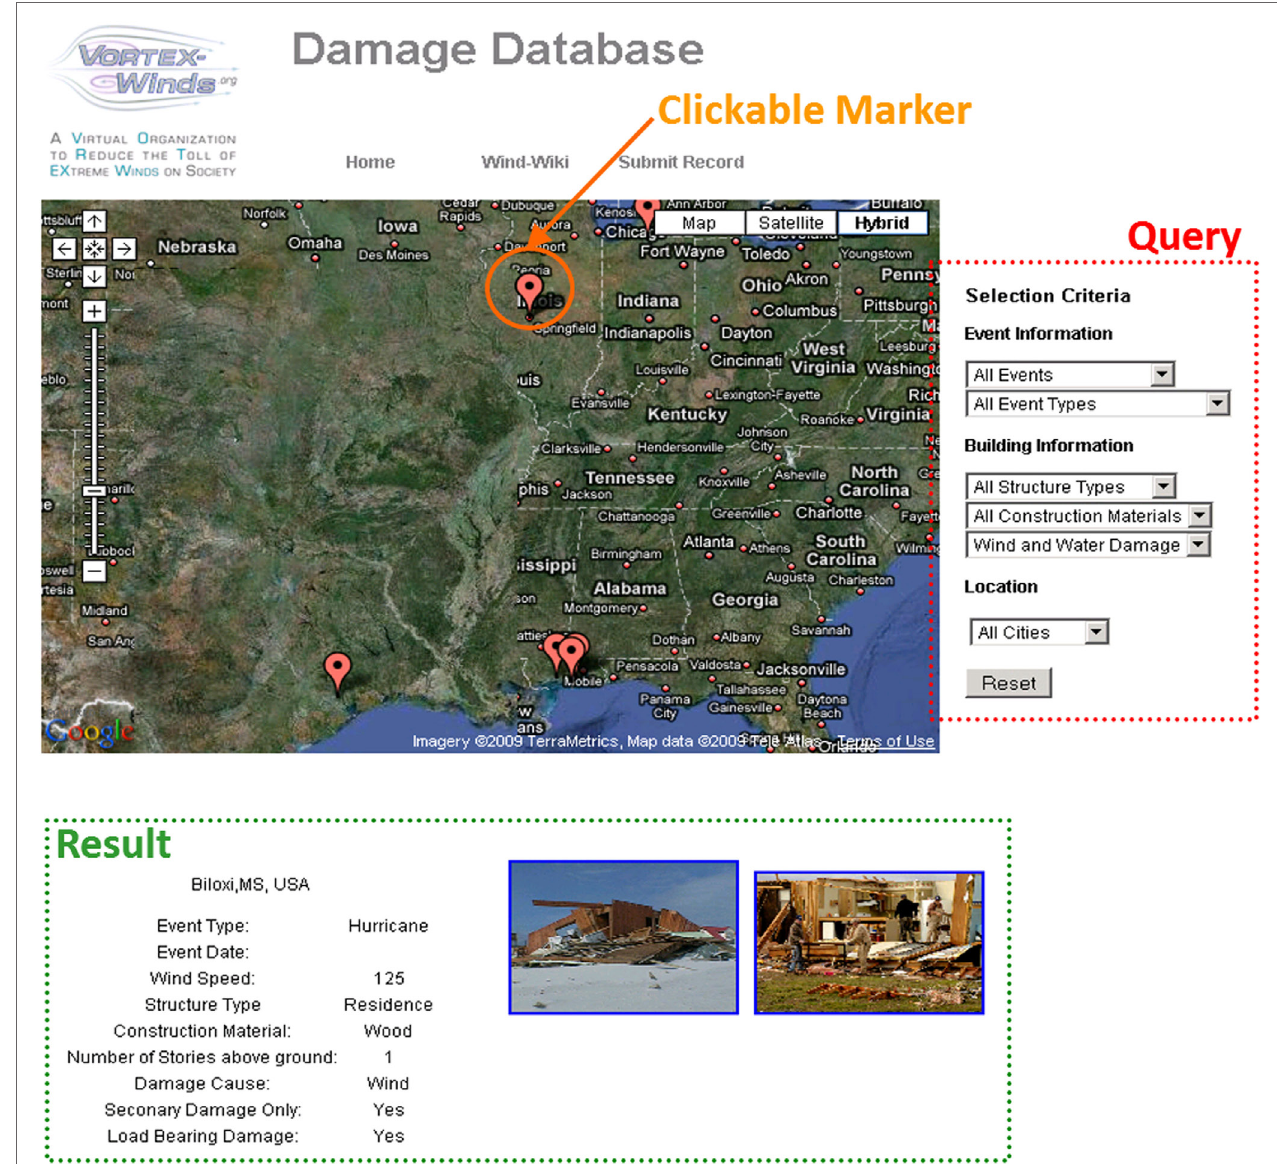
FigUre 3 | User interface of Damage database: damage archive in the Google map and query-based database search and damage information with